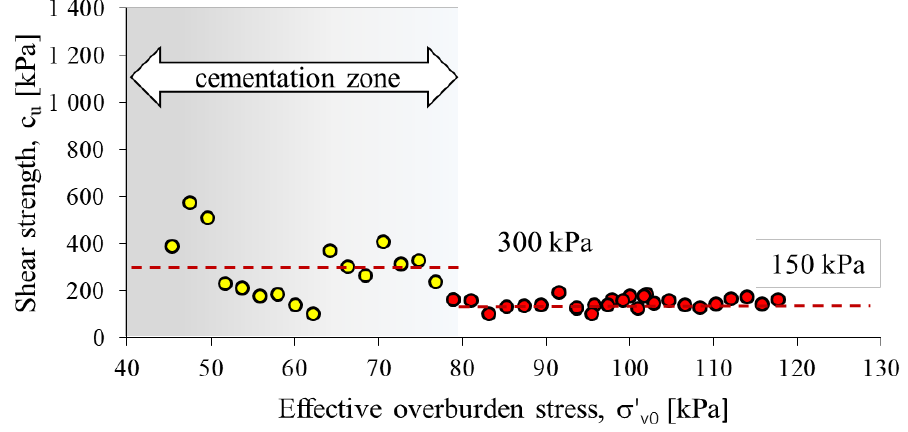
Figure 8. A comparison of shear strength values from CPTU for recommended values of N kt .